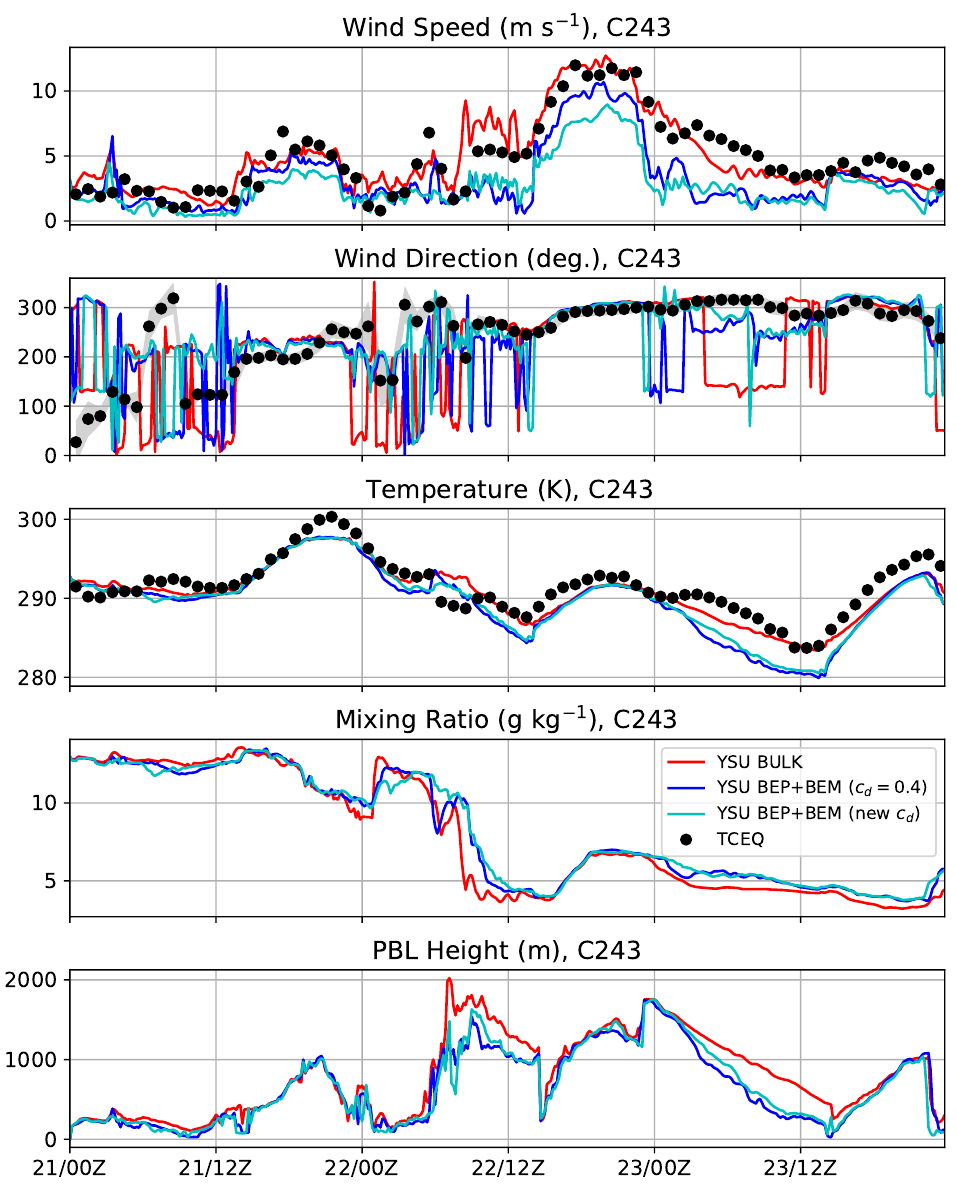
Figure 8. Same as Figure 7 but at LIR station